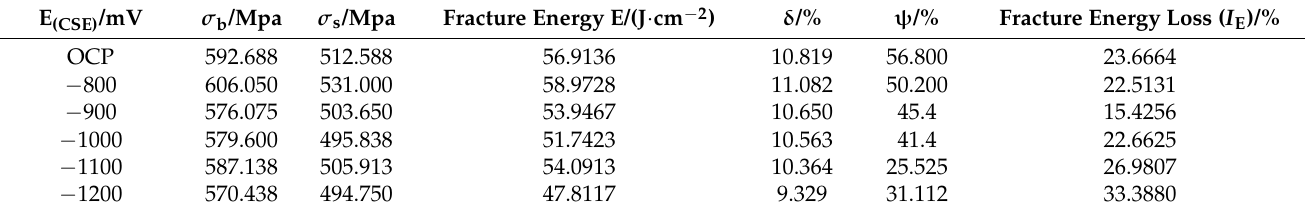
Table 4. The tensile properties of X80 under different CP potentials in soil medium at 60 ◦